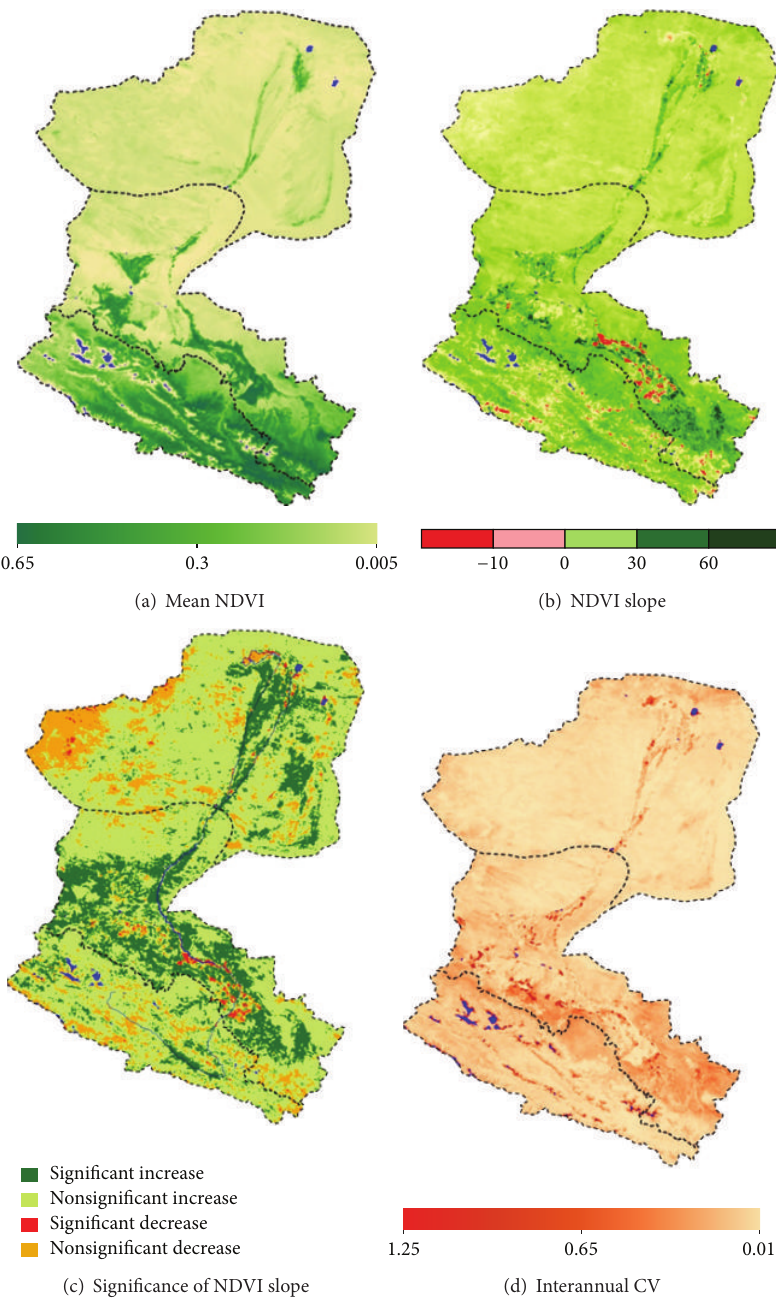
Figure 3: Vegetation dynamics in the Heihe River